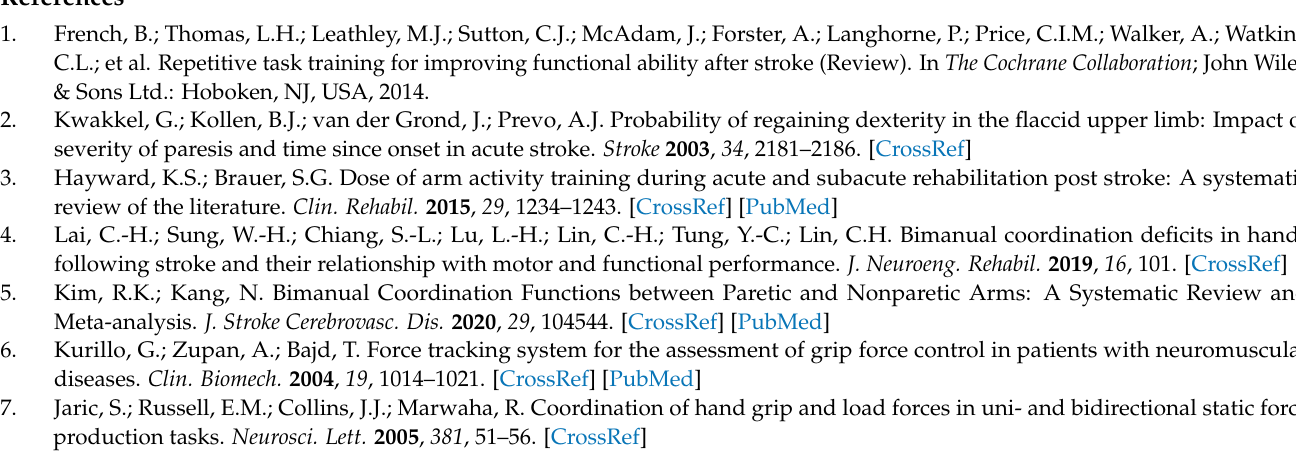
Table S4. Descriptive statistics for patients after cerebellar ischemic stroke in Groups I and II. Table S5. Comparison of patients with different types of strokes in terms of their range of motion, frequency of movement, and handgrip strength in sitting and lying positions with the upper limb against the patient’s body in Group I. Table S6. Comparison of patients with different types of strokes in terms of their range of motion, frequency of movement, and handgrip strength in sitting and lying positions with the upper limb against the patient’s body in Group